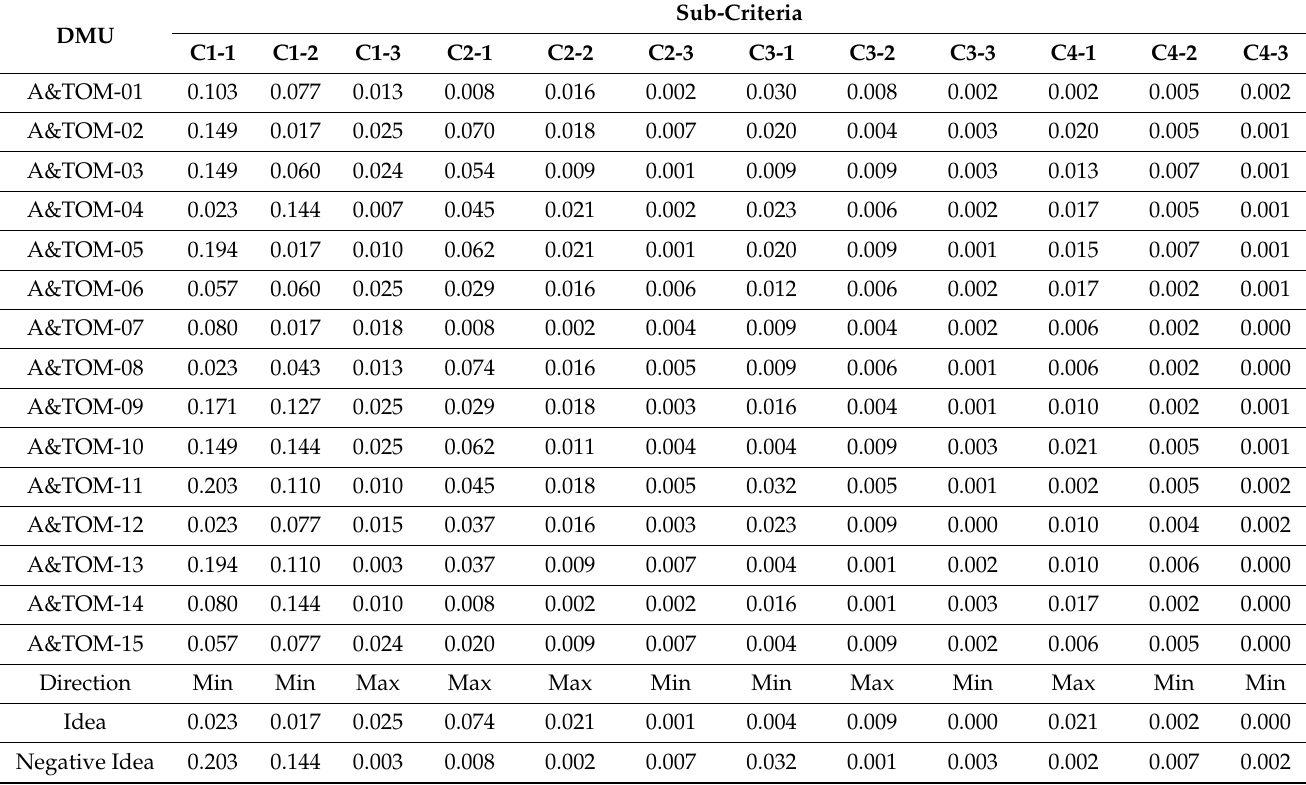
Table A5. Weighted normalized defuzzied decision